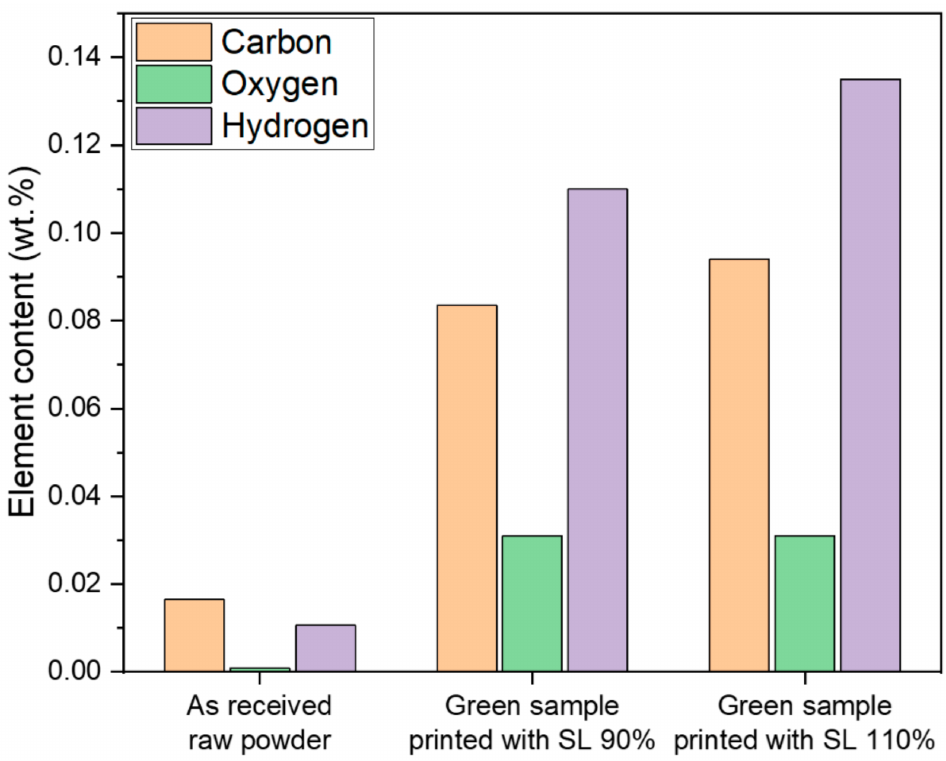
Figure 5. Elemental analyses of carbon, oxygen, and hydrogen in the as-received AZ91 powder and the green objects printed at 90% and 110%